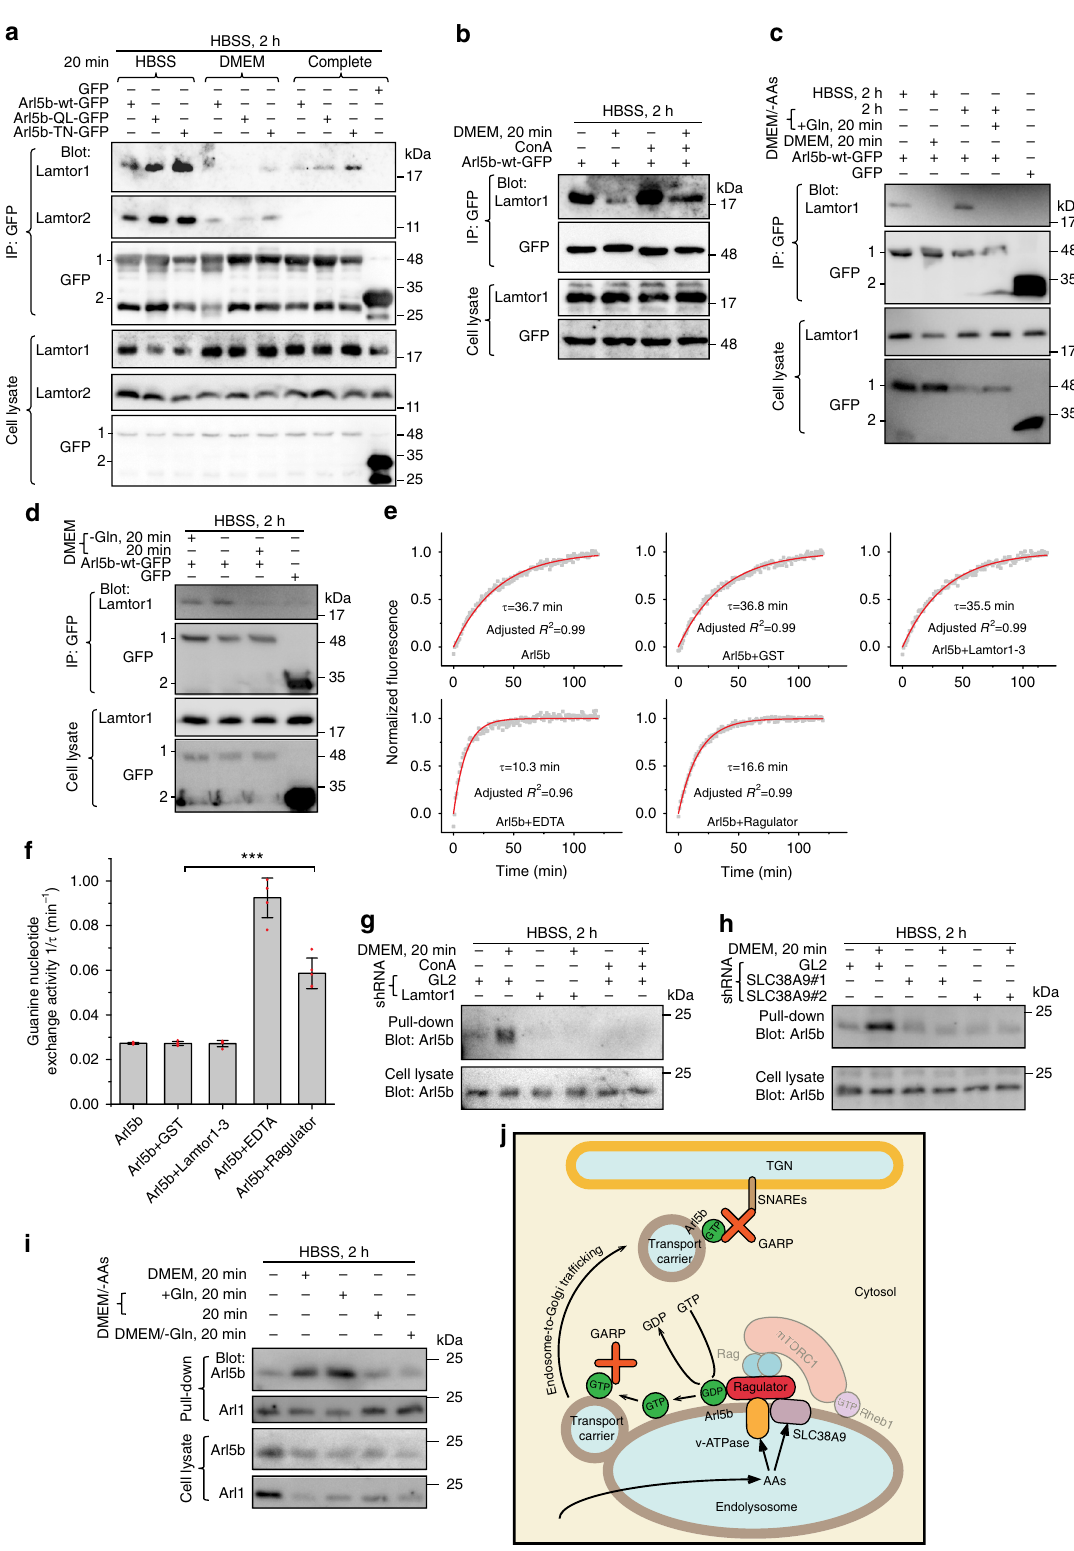
α -tubulin pAb (#ab4074) (1:1000 for WB), rabbit anti-EEA1 pAb (#ab2900) (1:1000 for WB; 1:500 for IF), rabbit anti-Giantin pAb (#ab24586)(1:1000 for IF), rabbit anti-GM130 pAb (#ab52649)(1:500 for IF), rabbit anti-TGN46 pAb (#50595)(1:400 for IF), and HRP-conjugated protein A (#ab7456)(1:3000 for WB). The following antibodies were from Santa Cruz: rabbit anti-GAPDH pAb